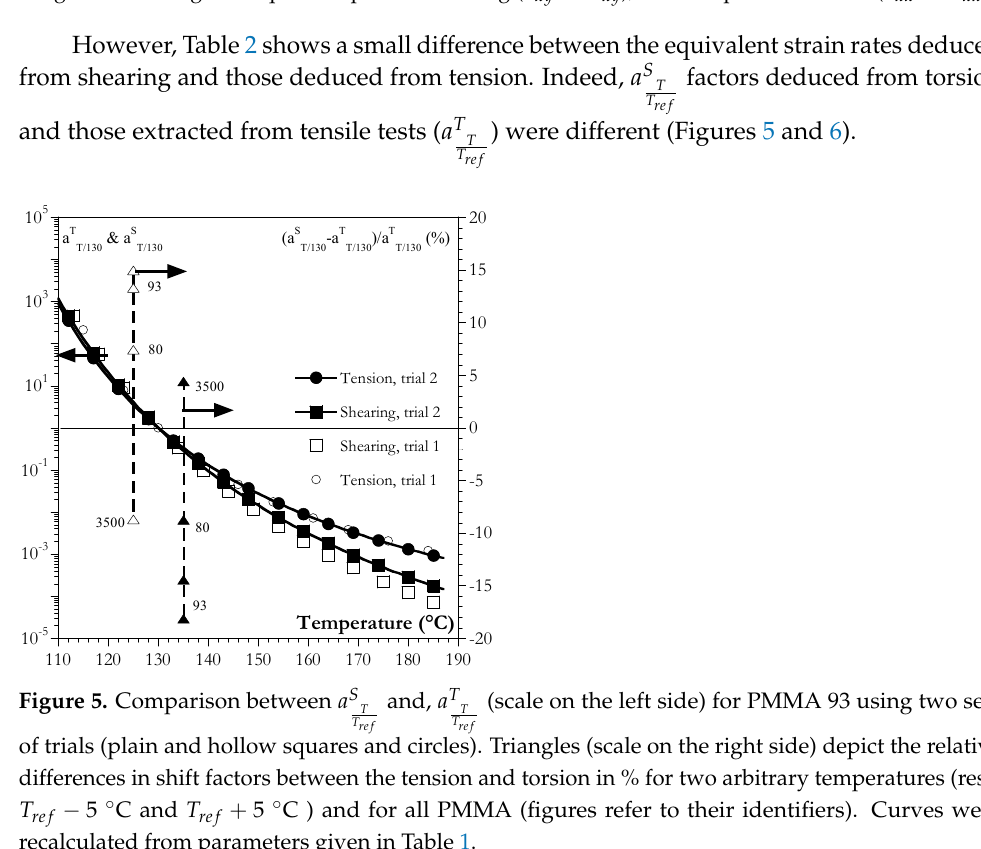
Figure 4. Comparison between tension and shearing for PMMA 80 at an equivalent strain rate of 10 − 2 s − 1 at 130 ◦ C. Stress ( σ ) vs. strain ( ε ) curves for two equivalent experimental sets of conditions are given in the legend. Squares represent shearing ( σ xy vs . ε xy ); circles represent tension ( σ xx vs . ε xx ).